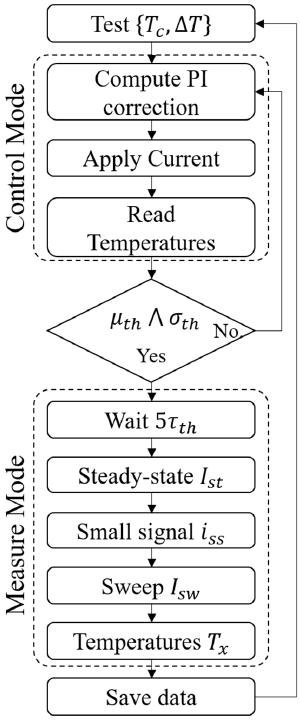
Figure 5. Test procedure flowchart.